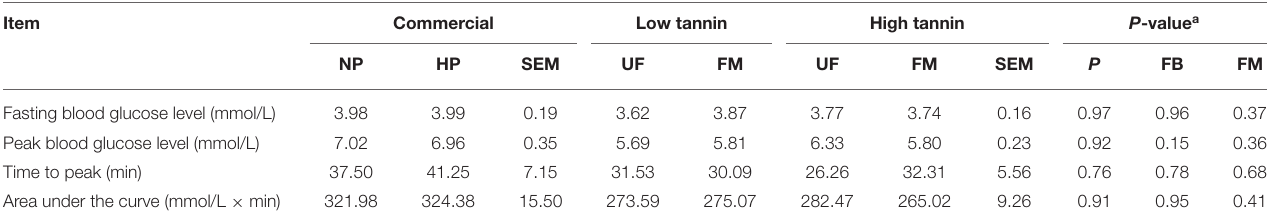
TABLE 2 | Fasting and peak blood glucose levels, time to peak, and area under the curve of dogs fed diets formulated with either low or high tannin fava beans without (UF) or with (FM) fermentation, or normal (NP) vs. high (HP) protein commercial diets for 7 days each * . Item Commercial Low tannin High